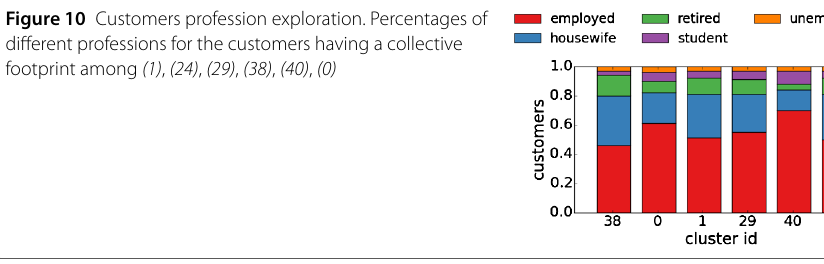
Figure 10 Customers profession exploration. Percentages of different professions for the customers having a collective footprint among (1) , (24) , (29) , (38) , (40) ,